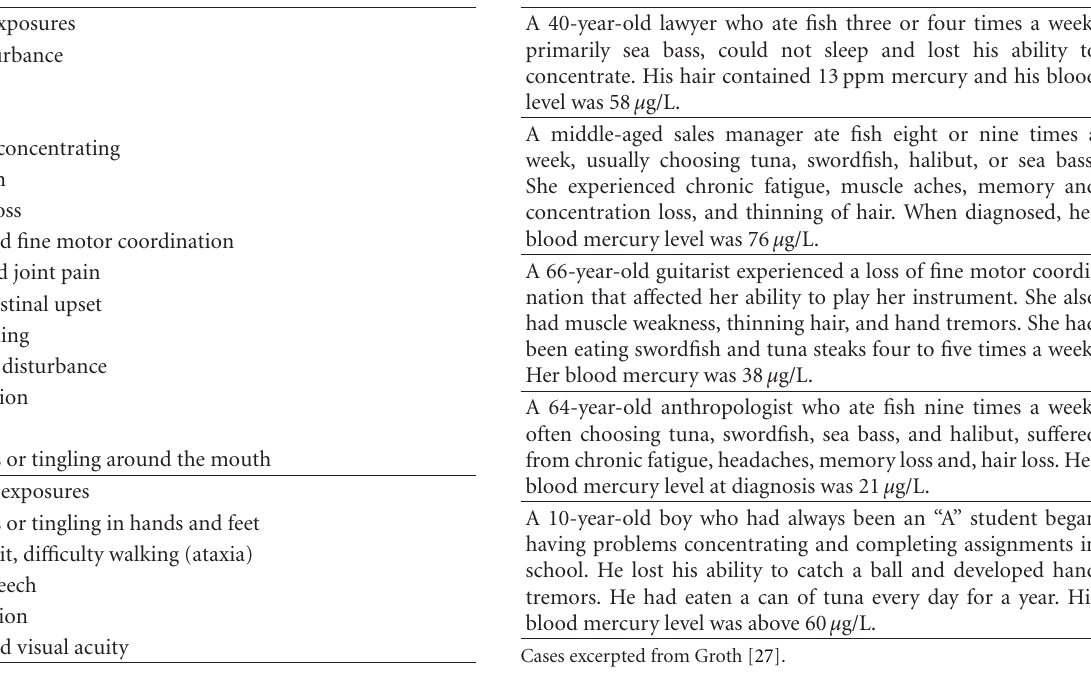
Table 2: Signs and symptoms of MeHg poisoning. Table 3: Cases of MeHg